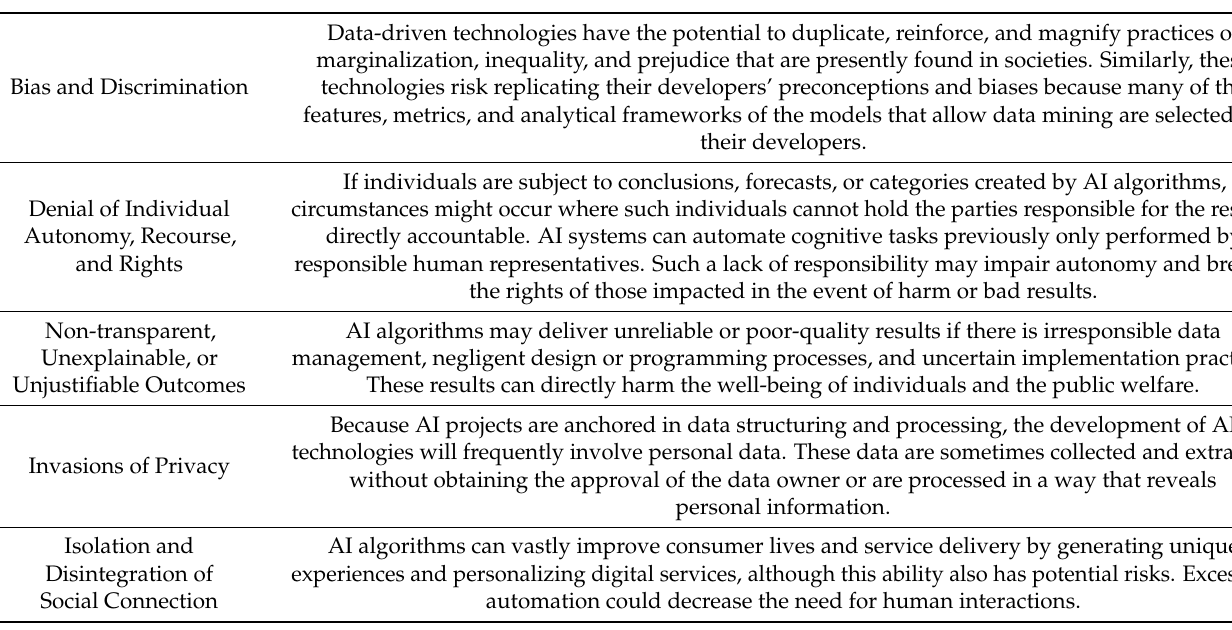
Table 1. Risks of artificial